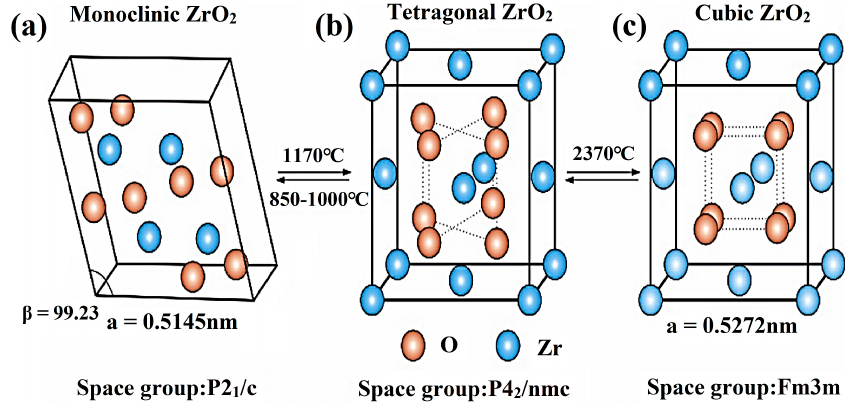
Figure 1. Schematic representation of crystal structures of ZrO 2 ( a ) monoclinic ZrO 2 , ( b ) tetragonal ZrO 2 , and ( c ) cubic ZrO 2 , reprinted with permission from Elsevier (License NO. 5332051438018) [34].